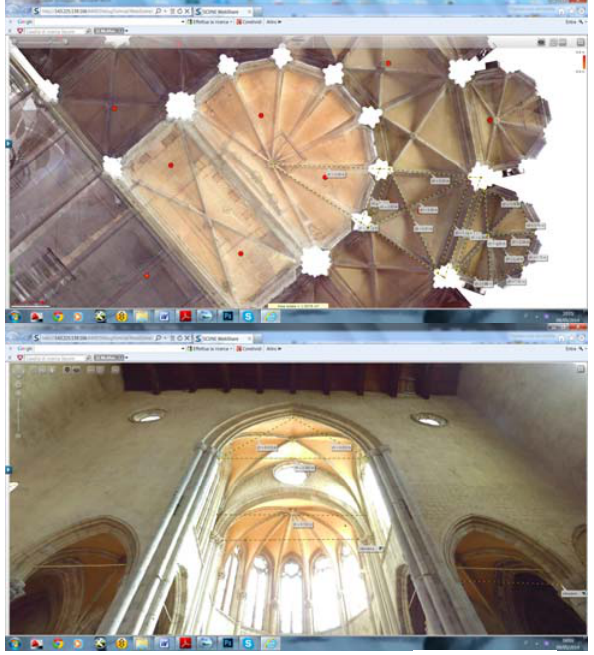
Figure 6 . Naples S. Lorenzo Maggiore. Survey data from SCENE WebShare